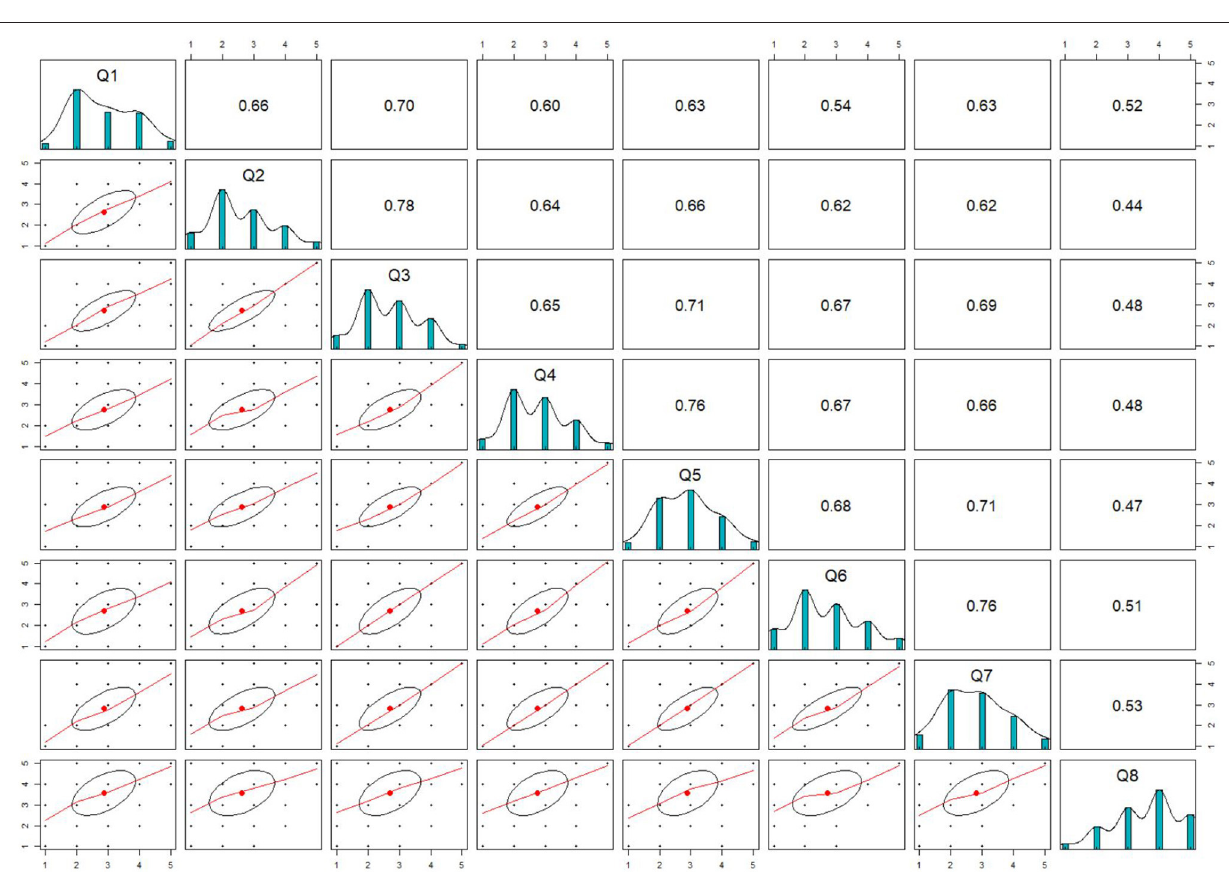
FIGURE 2 | The visualization of the descriptive statistics for the eight